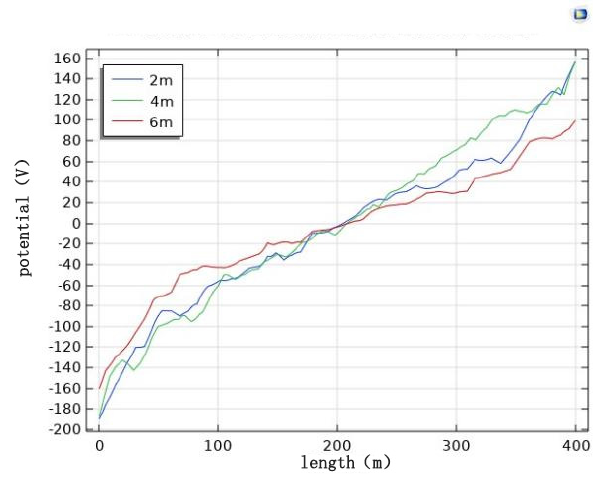
Figure 28. The influence law of burial depth on the cathodic protection potential.